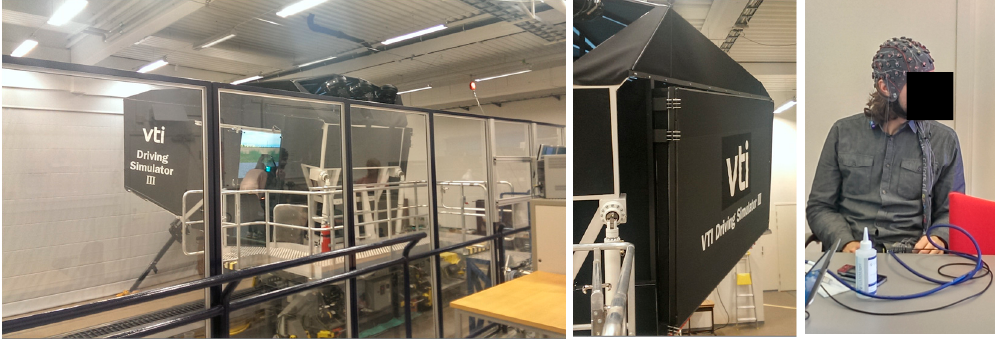
Figure 1. VTI simulator III and electroencephalography (EEG) electrodes setup on a